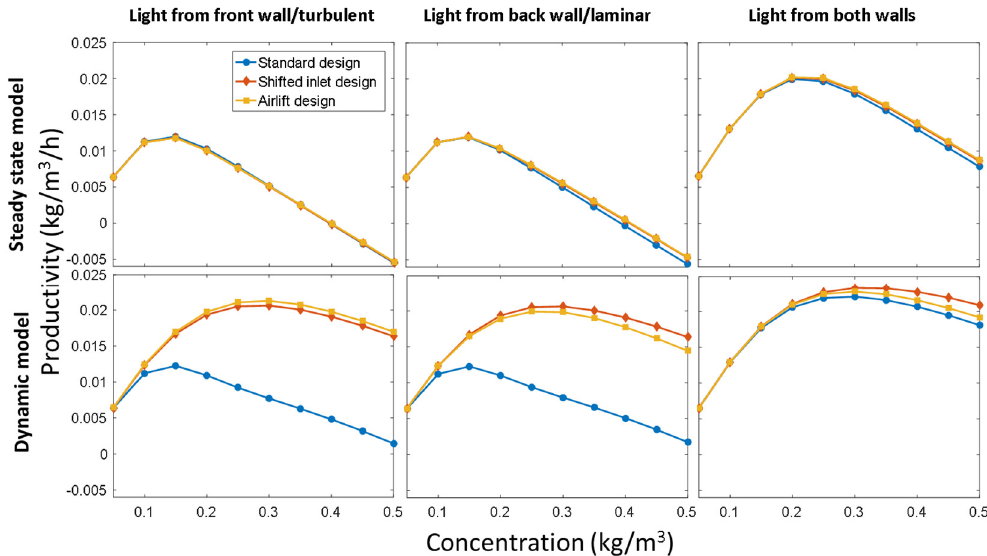
Figure 9. Biomass productivity at different microalgal concentrations for different light incidence schemes, different growth models, and different reactor designs. The parameter values used in the dynamic model were k 21 = 0.1 s −1 and k 23 = 10 −4 m 2 /μE, air inlet flowrate was 0.5 L/min, and incident light intensity was 1000 μE/m 2 s.